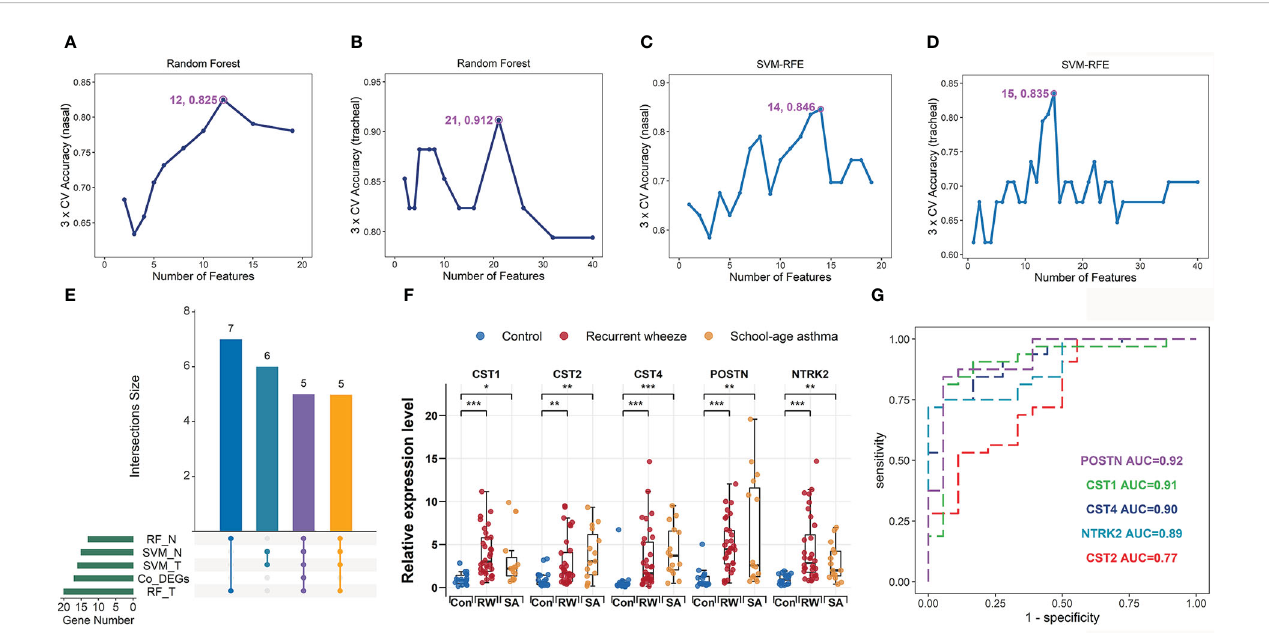
FIGURE 1 Identi fi cation and validation of hub genes shared by RW and SA. Process of identifying hub genes using random forest (RF) algorithm across nasal (A) and tracheal samples (B) . Identifying hub genes based on support vector machine-recursive feature elimination (SVM-RFE) across nasal (C) and tracheal samples (D) . X-axis denotes number of feature genes; y-axis represents classi fi cation accuracy. Annotated numbers represent number of feature genes corresponding to maximum classi fi cation accuracy. (E) UpSet diagram showing 16 overlapping hub genes between co-DEGs and candidate hub genes screened by two machine learning algorithms. (F) qRT-PCR validation of POSTN, CST1, CST2, CST4, and NTRK2 expression in bronchoalveolar lavage (BAL) cells from controls, patients with SA, and preschoolers with RW. Statistical signi fi cance was assessed using Wilcoxon rank-sum test. Asterisks indicate P -values for RW or SA versus control. * P < 0.05, ** P < 0.01, *** P < 0.001. (G) ROC curves evaluating discriminatory power of hub genes for children with RW. AUC, area under ROC curve; co-DEGs, common differentially expressed genes; con, control; N, nasal; qRT-PCR, quantitative reverse- transcription polymerase chain reaction; ROC, receiver operating characteristic; RW, recurrent wheezing; T,